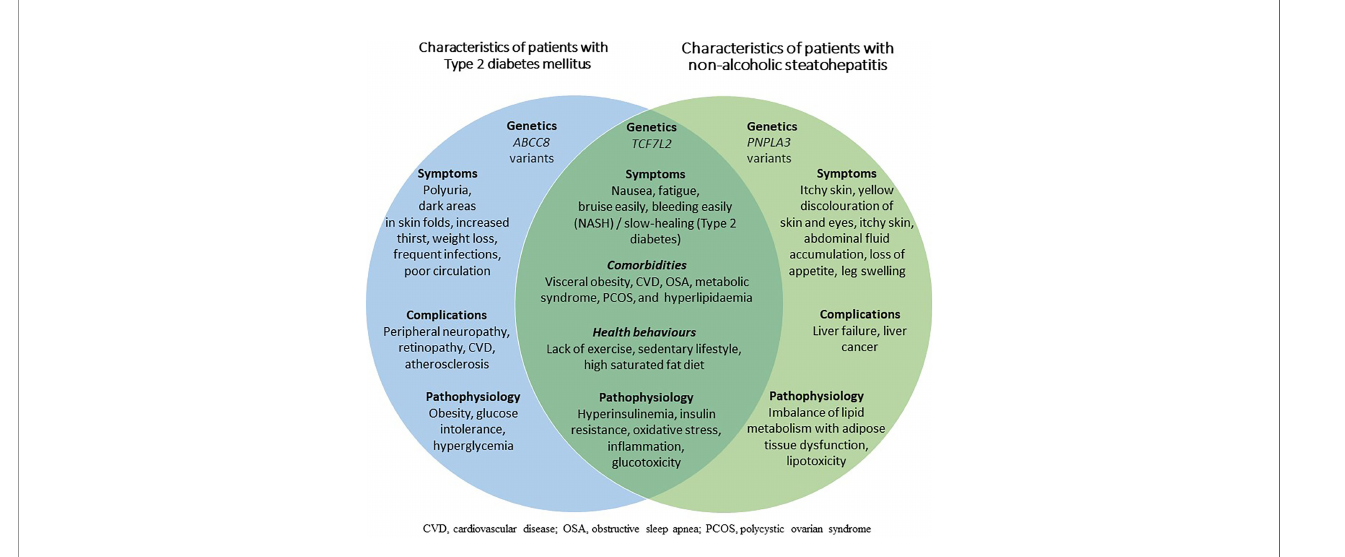
FIGURE 1 | A Venn diagram of the symptoms, pathological features, and genetic features of type 2 diabetes and non-alcoholic